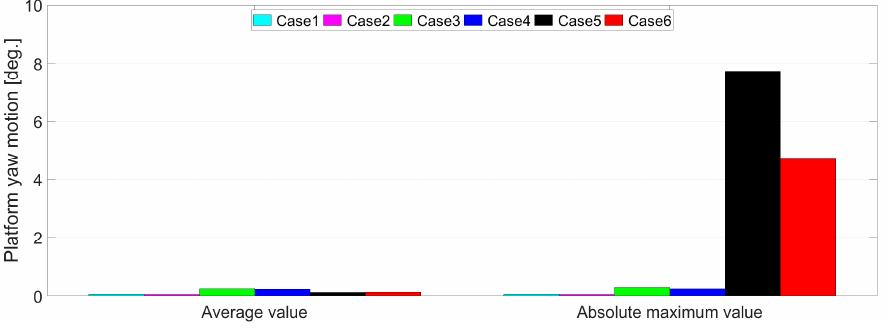
Figure 10. Average and absolute maximum values of the platform yaw’s motion for all conditions.